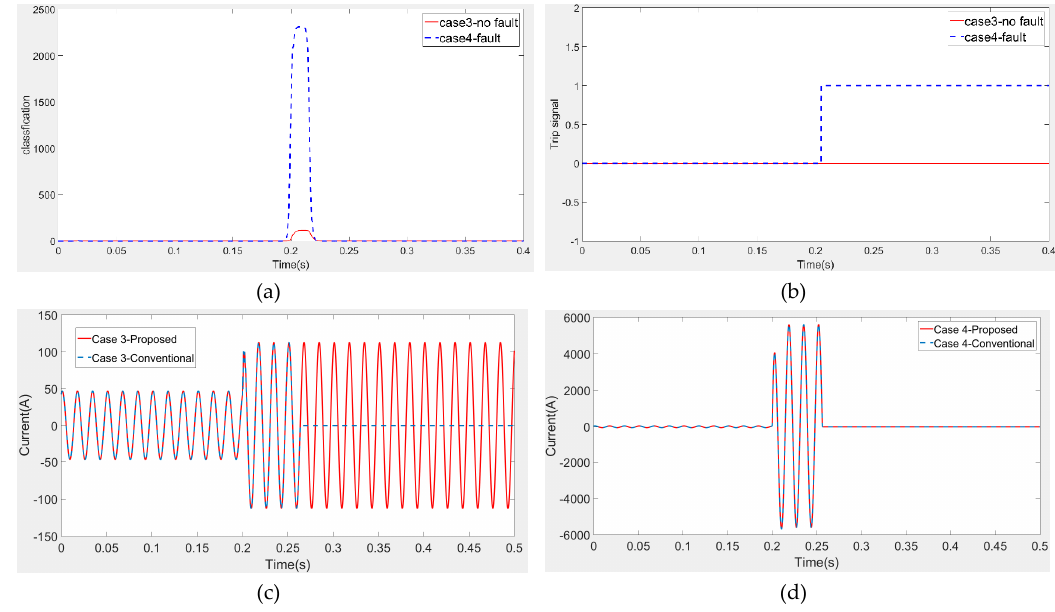
Figure 18. Simulation results of case 3 and 4. (a) Calculation result of classification value; (b) Trip signal; (c) Current flowing in the Y line in case 3; (d) Current flowing in the Y line in case 4.